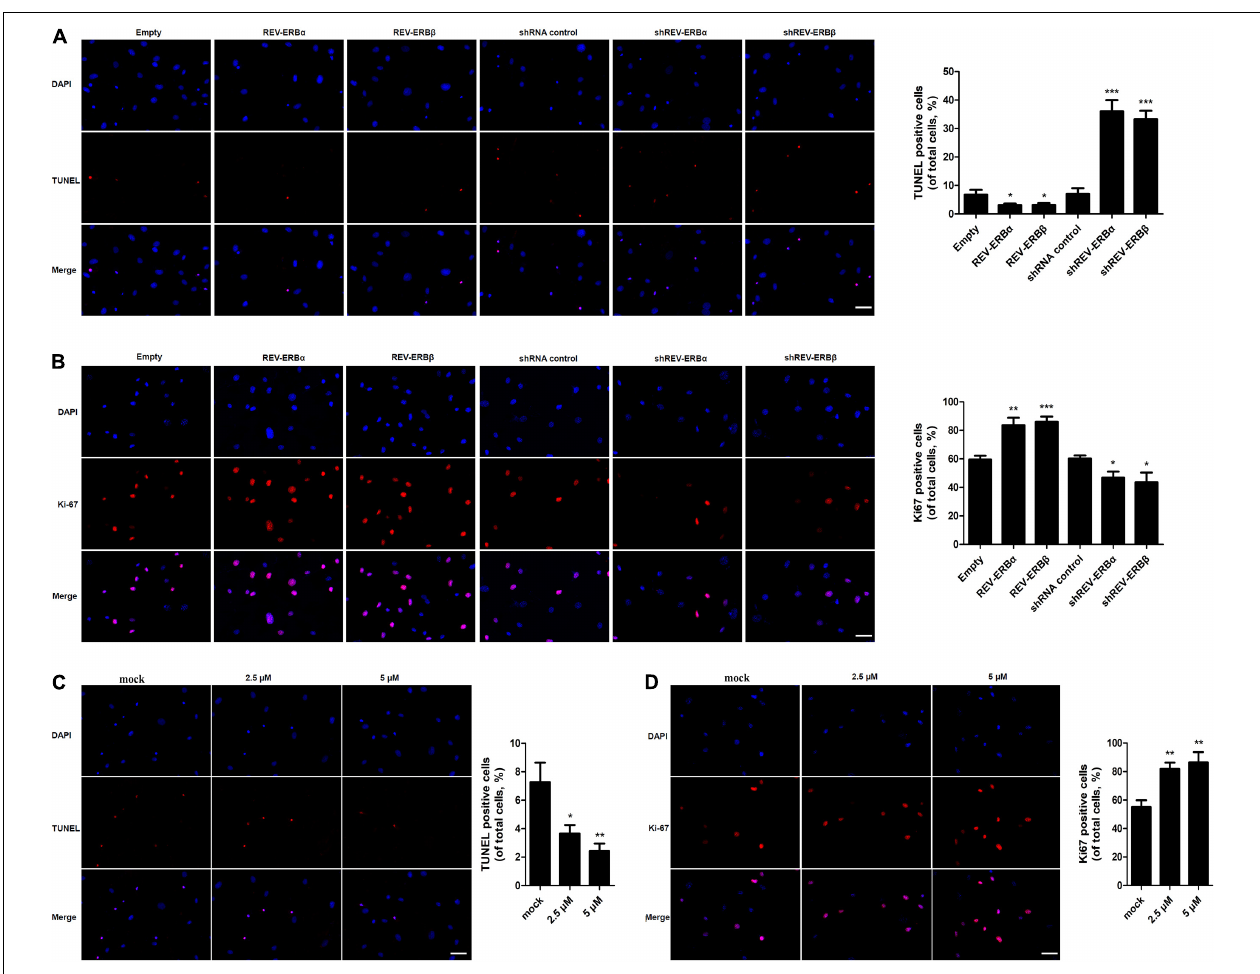
FIGURE 5 | REV-ERBs and its agonist SR9009 inhibit apoptosis and promote the proliferation of KGN cells. KGN cells transfected with empty vector, REV-ERB α , REV-ERB β , shRNA control, shREV-ERB α , or shREV-ERB β plasmid for 48 h. (A) Granulosa cell apoptosis was assayed by TUNEL. Scale bars: 50 µ m. Blue fluorescence represents DAPI staining; Red fluorescence represents TUNEL staining. (B) Granulosa cell proliferation (Ki67-positivity) was assessed by immunofluorescence. Scale bars: 50 µ m. Blue fluorescence represents DAPI staining; Red fluorescence represents Ki-67 expression. KGN cells were treated with different concentrations of SR9009 (2.5, 5 µ M) or mock-treated (mock) for 72 h. (C) Granulosa cell apoptosis was assayed by TUNEL assay. Scale bars: 50 µ m. Blue fluorescence represents DAPI staining; Red fluorescence represents TUNEL staining. (D) Granulosa cell proliferation (Ki67-positivity) was assessed by immunofluorescence. Scale bars: 50 µ m. Blue fluorescence represents DAPI staining; Red fluorescence represents Ki-67 expression. * P < 0.05, ** P < 0.01, *** P < 0.001 vs. empty vector or mock.